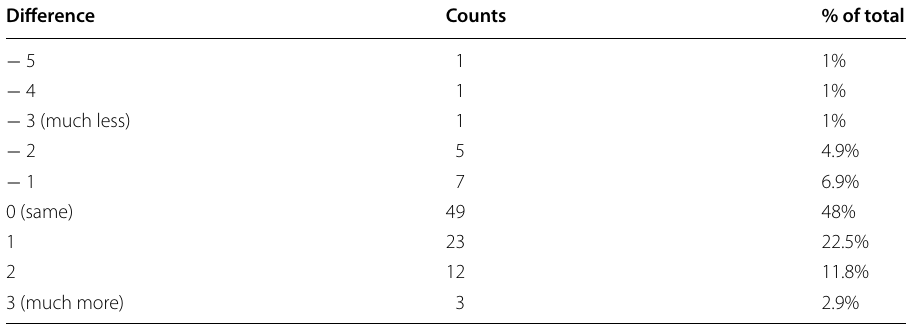
Table 2 Teaching load change during ERT Difference